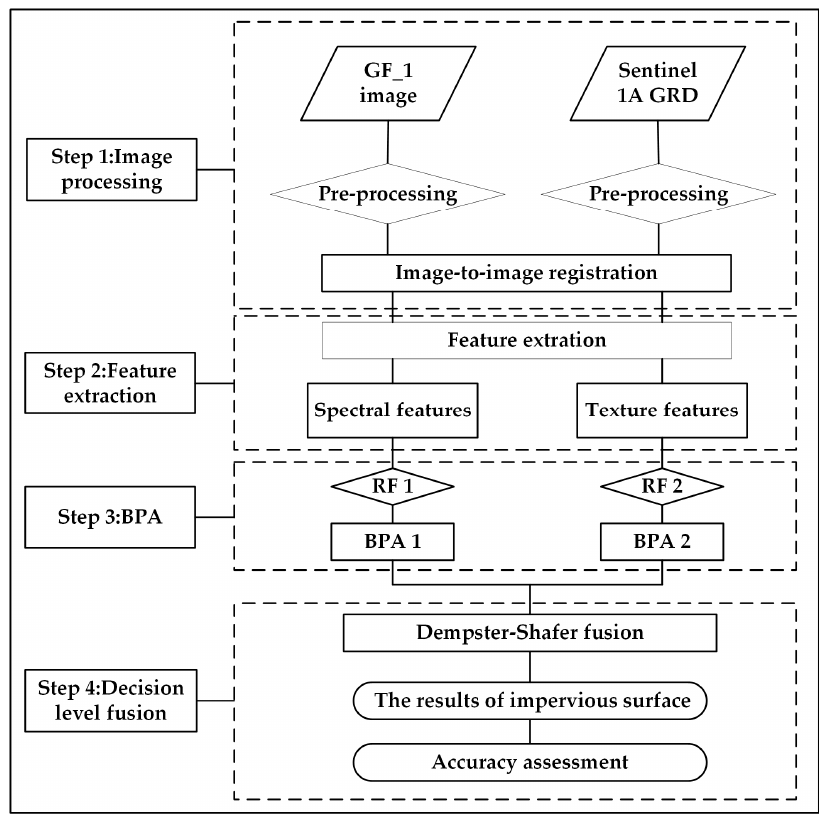
Figure 2. The overall workflow for extracting urban impervious surfaces by fusing optical and synthetic aperture radar (SAR) data.